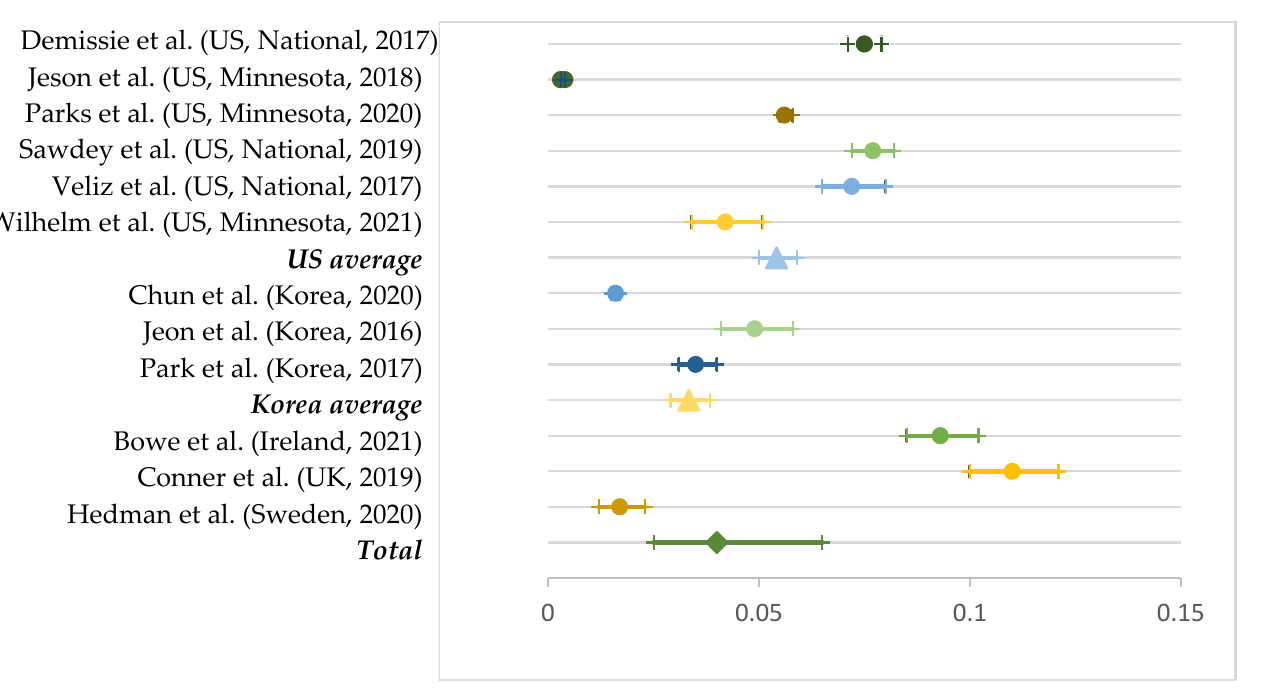
Figure 4. Prevalence of current dual use by country [8,23,27,30,48,49,54,56,66,68,74,77]. Note. Na- tional average is presented with the shape of a triangle and the total pooled prevalence as rhom- bus.